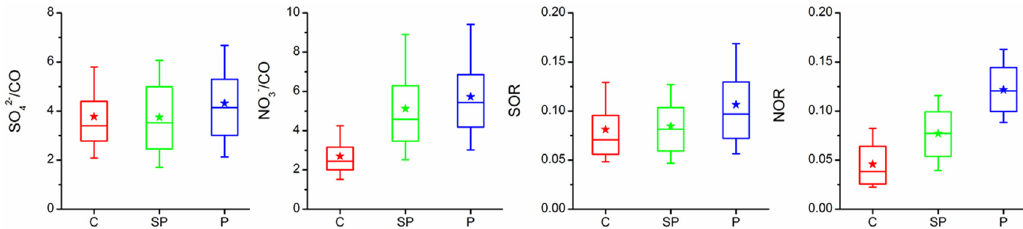
Figure 3. Time series of PM 1 components (sulfate, nitrate, and ammonium).